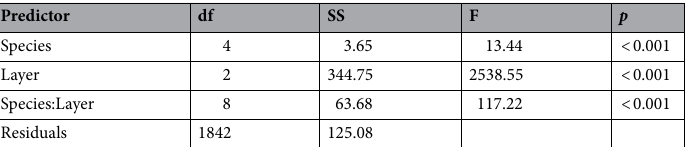
Table 2. ANOVA table testing for the effect of species identity and height layer on daily differences in canopy temperatures (ΔT, temperatures mean centered per day); df = degrees of freedom, SS = sum of squares, F = F-value, p = p